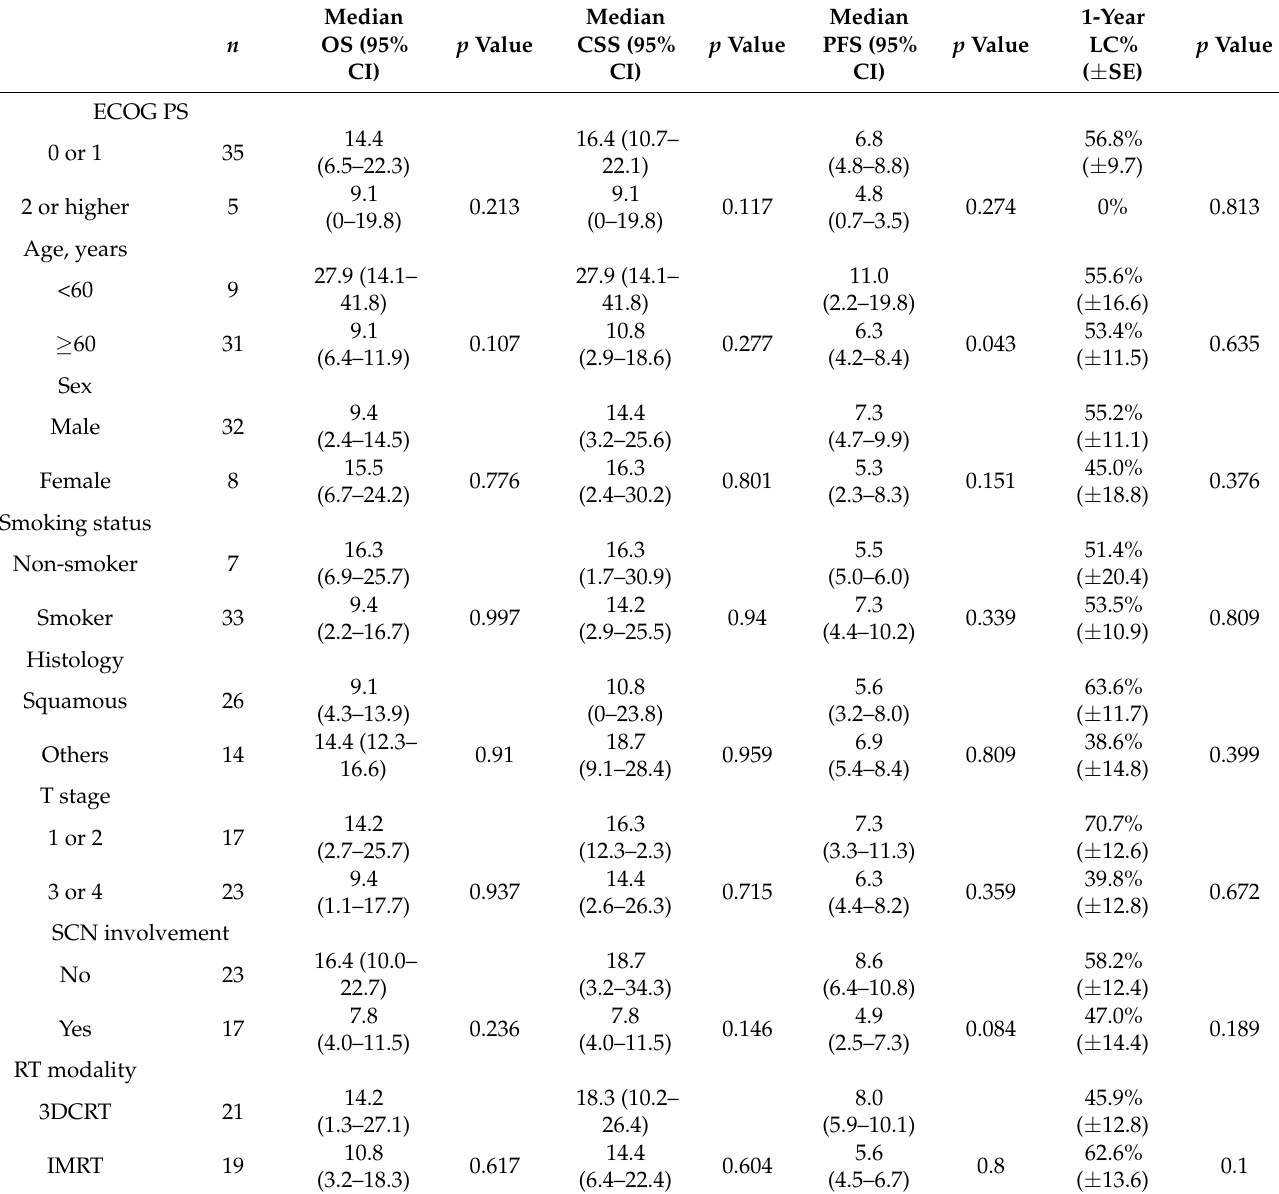
Table 2. Univariate analysis of OS, CSS, PFS, and LC rates in all